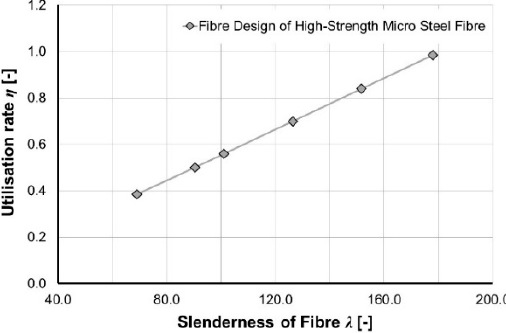
Figure 7. Slenderness of investigated high-strength micro steel fibre in relation to the utilisation rate.